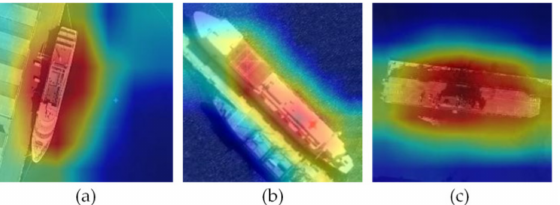
Figure 11. Grad-CAM visualization of remote sensing ship images. ( a – c ) are the visualization results of YA, AH and LHA, respectively. It can be seen that Grad-CAM can locate the ship in the image very